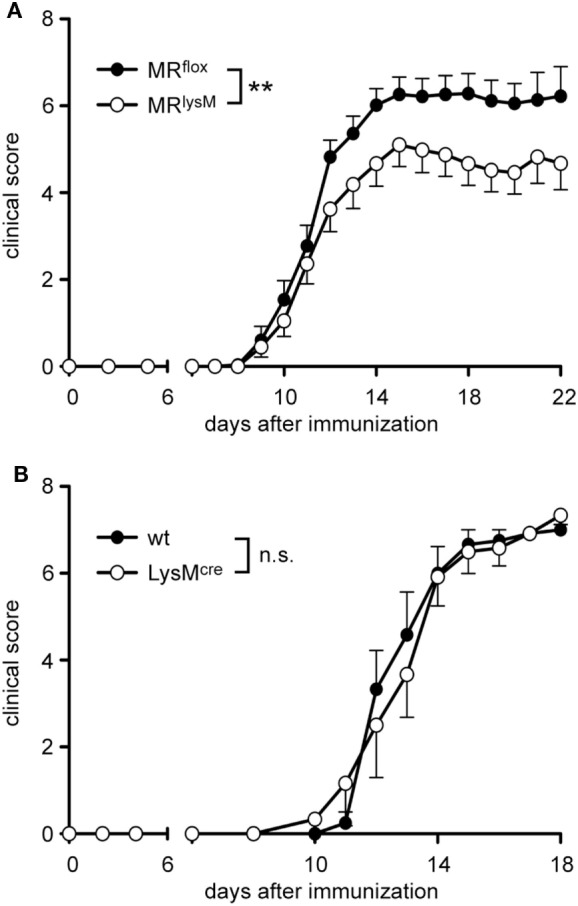
Clinical experimental autoimmune encephalomyelitis (EAE) score of MRlysM and LysMcre mice. EAE was induced by immunization with MOG35–55 in CFA. (A) Disease course of MRflox and MRlysM mice. n = 25/29, pooled from three individual experiments. (B) The disease course of wild-type and LysMcre mice was monitored over a period of 18 days. n = 6/6. Data are presented as mean ± SEM (n.s., not significant, **p < 0.01).